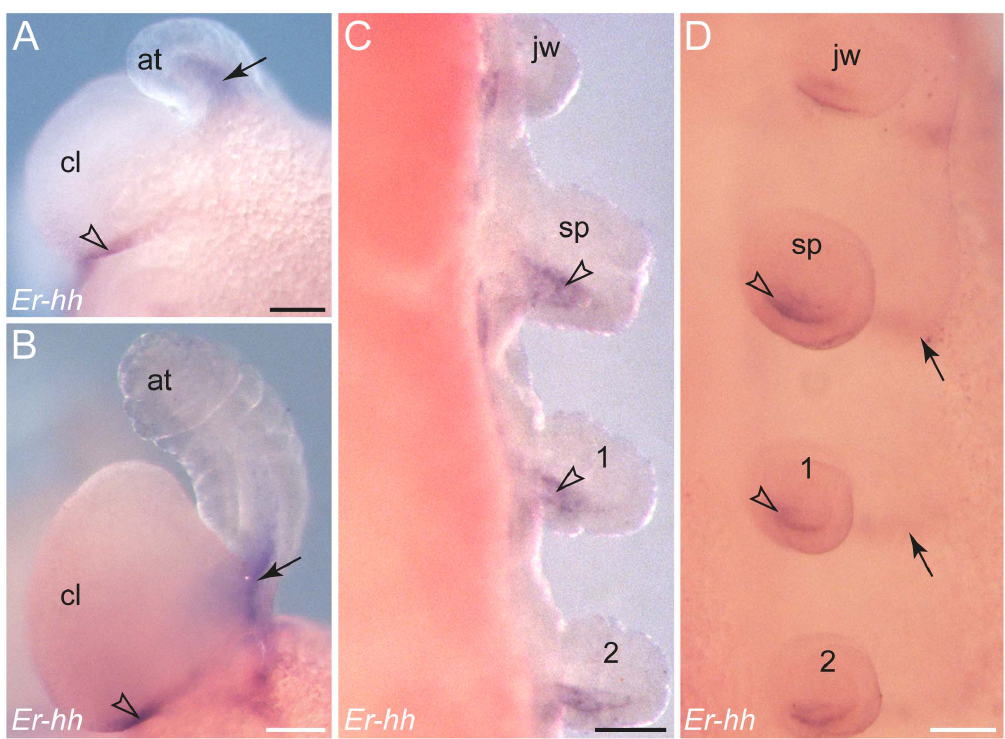
Figure 11. Details of hedgehog expression in embryos of E. rowelli . Leg-bearing segments and corresponding limbs are numbered. (A, B) Anterior ends of a stage III and a stage IV embryo in lateral view. Arrows point to the expression in the mesoderm of the developing antennae, whereas arrowheads indicate the expression at the posterior border of the cephalic lobe. (C, D) Details of limbs in a stage IVembryo in dorsal (in C) and ventro-lateral views (in D). Arrowheads indicate the expression in the mesoderm of each developing limb, although expression is also evident in the ectoderm of limb anlagen. Arrows point to stripes of expression in the ventral ectoderm. Abbreviations: at , antenna; cl , cephalic lobe; jw , jaw segment; po , proctodaeum; sp , slime papilla. Scale bars: 100 m m